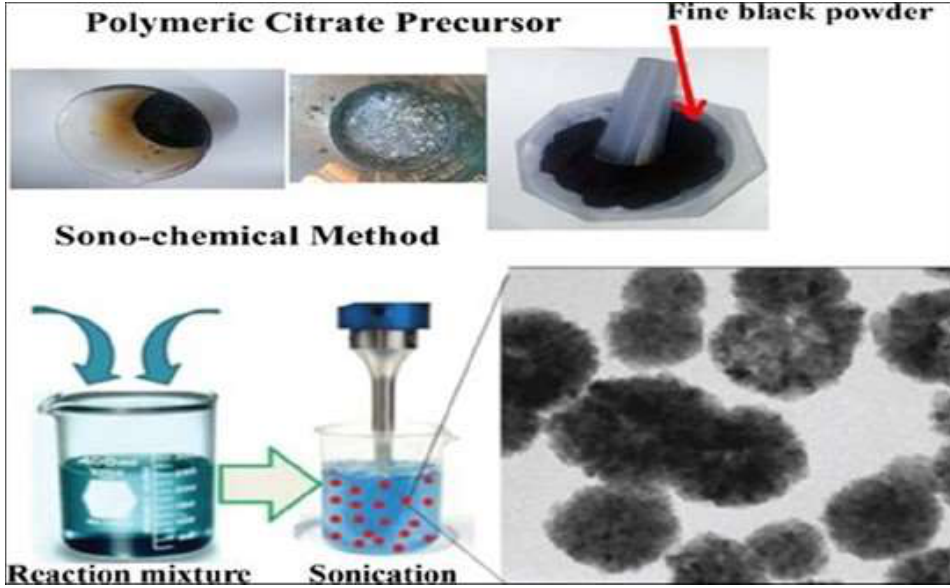
Figure 7: Illustration of Citrate Pyrolysis Technique